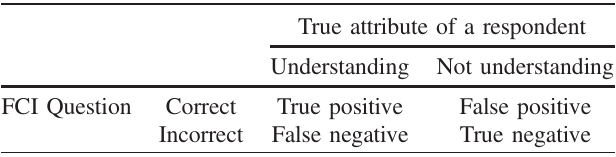
TABLE I. Contingency table of